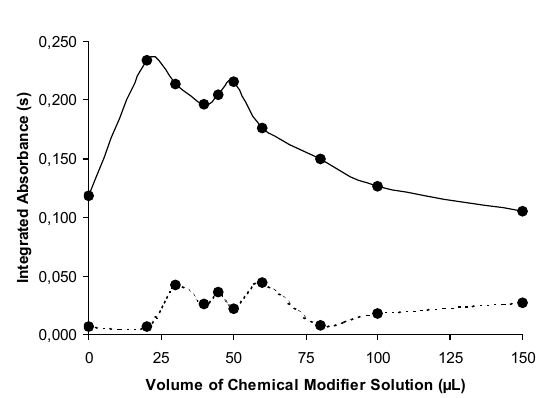
Figure 2. Effect of the amount of chemical modifier on the signal recorded for a 37.0 µg L -1 antimony standard solution. Solid line: atomic absorption; dotted line: background